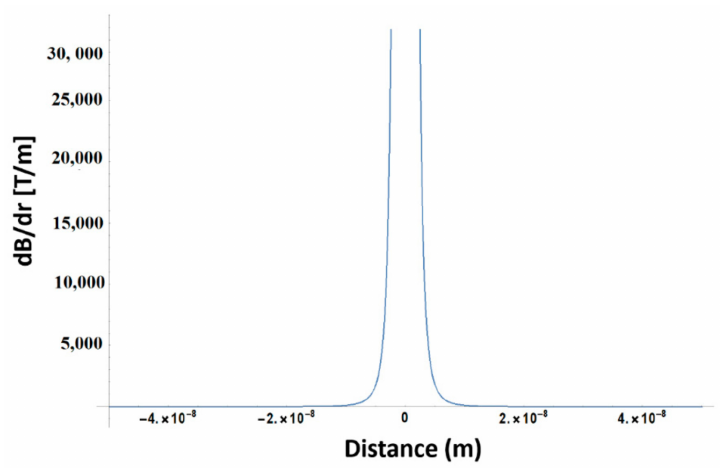
Figure 9. Magnetic field gradient between two adjacent